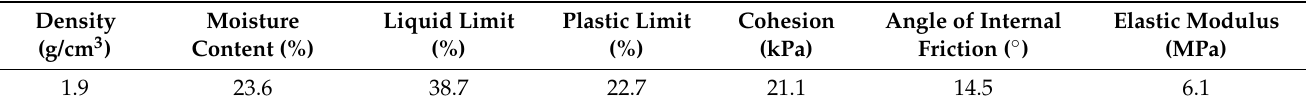
Table 1. Basic parameters of undisturbed